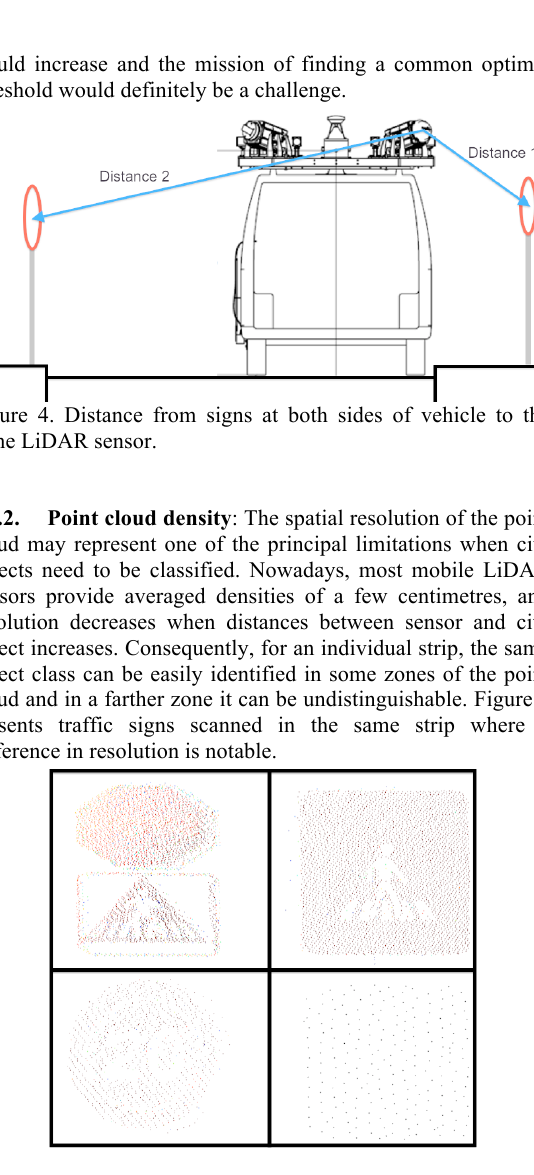
Figure 5. Differences in the resolution of traffic signs scanned from the same